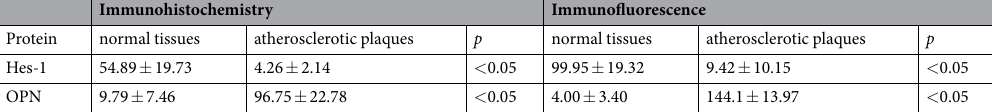
Table 2. Comparison of Hes-1, OPN concentrations in atherosclerotic plaques and normal arterial intimal tissues using Immunohistochemistry, Immunofluorescence and Image Analysis. Figure presented are mean optical densities minus background staining from negative slides ± standard error. Hes-1, hairy/enhancer of split homologue-1; OPN indicates